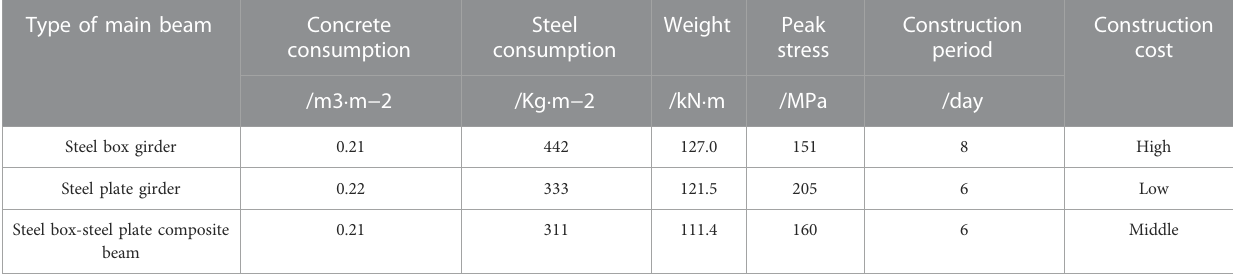
TABLE 5 Comparison of technical indexes of 30 m span girder. Type of main